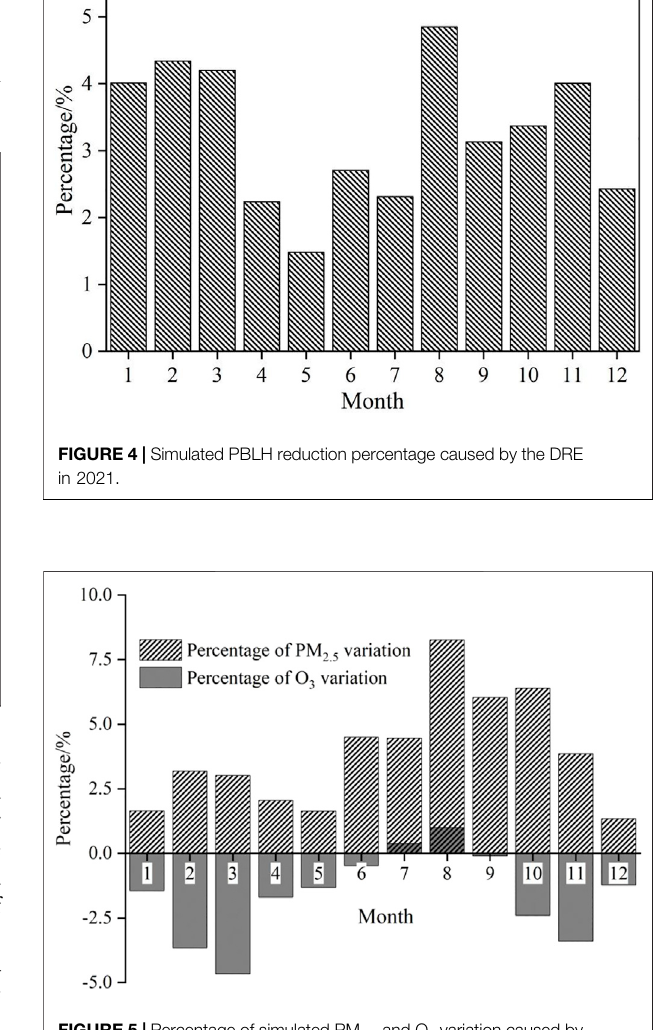
FIGURE 5 | Percentage of simulated PM 2.5 and O 3 variation caused by the DRE in